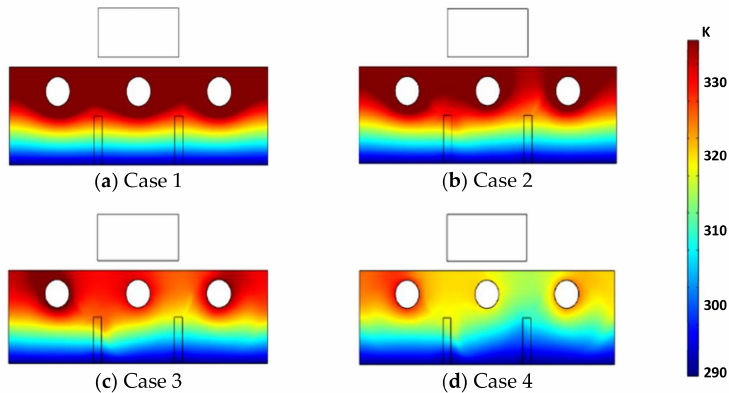
Figure 10. Velocity contours in the case of VGs (Case D).